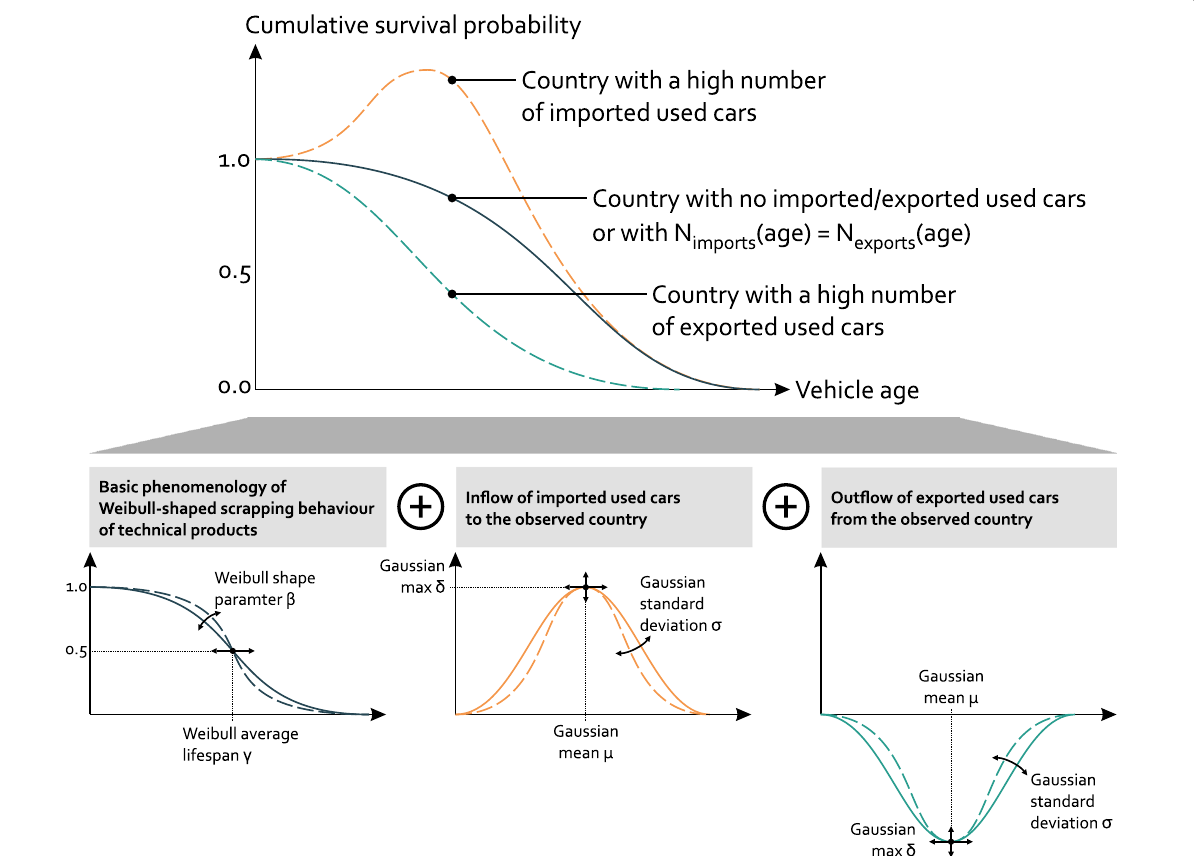
Fig. 1 Characteristic cumulative survival probability (CSP) curves. Countries with no imports/exports (dark blue), high imports (orange), and high exports (turquoise) of used cars. The upper panel depicts the raw CSP data resulting from Eq. 1, while the lower panel illustrates how this raw data can be fitted phenomenologically. Fitting parameters β , γ , δ , μ , and σ refer to the Weibull and Gauss distributions (Eqs. 2 and